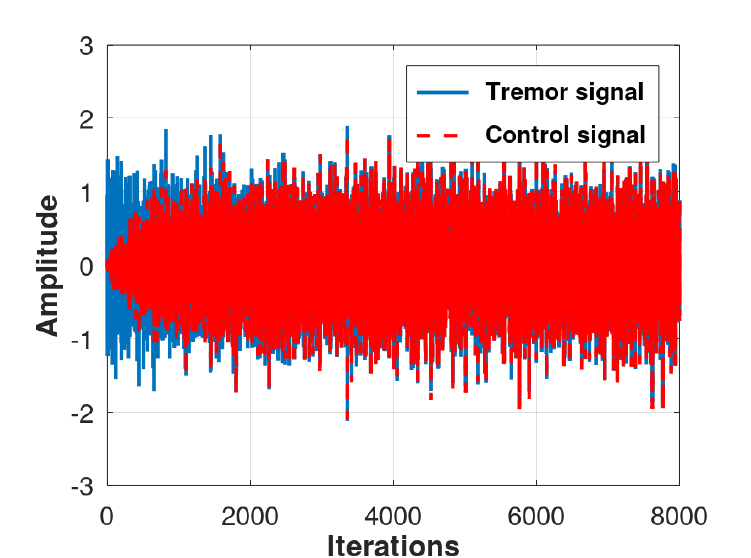
Figure 6. Control evaluation results produced by the Fx-LMS algorithm for 30 runs of a Monte Carlo simulation.